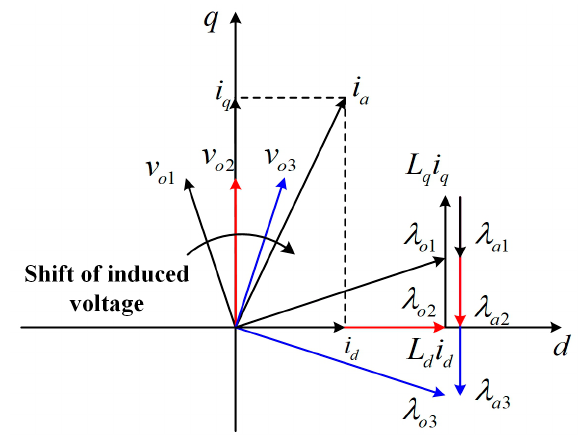
Figure 2. The vector diagram of LS-PMA-SynRM according to flux linkage by permanent magnet.